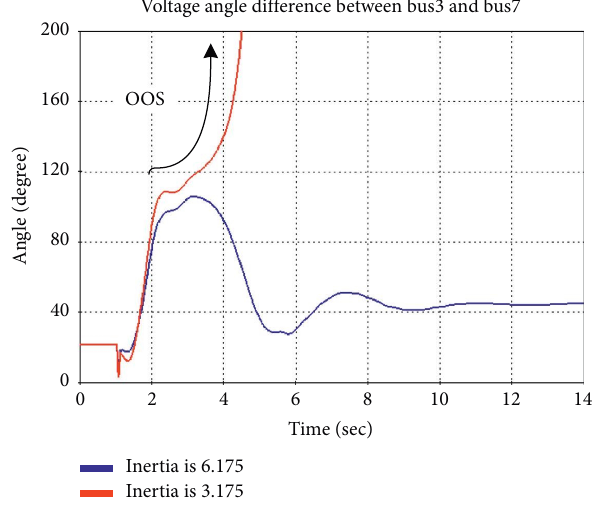
Figure 16: Efect of changing inertia on voltage angle